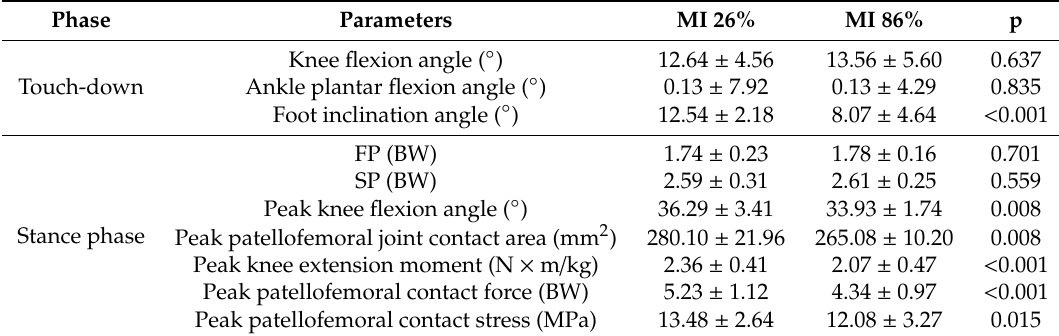
Table 2. Sagittal plane kinematics and kinetics during running with two di ff erent shoe conditions ( x ±